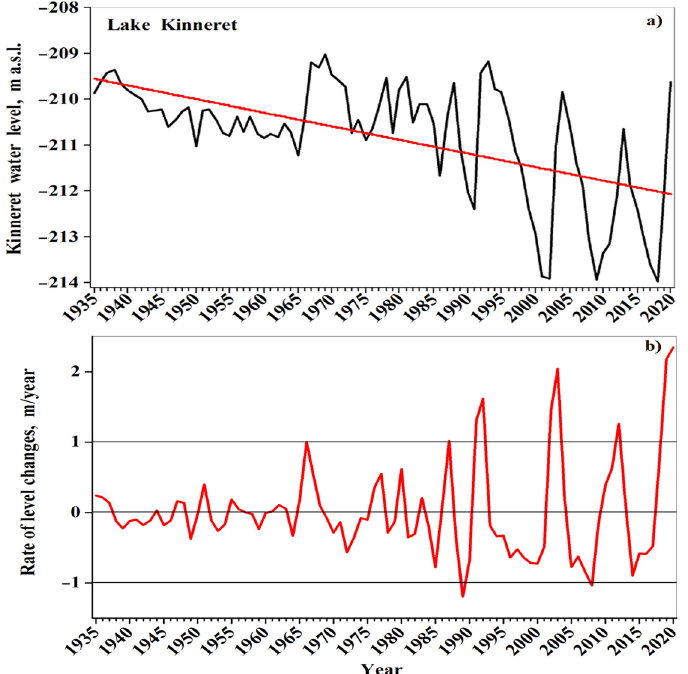
Figure 2. ( a ) Yearly data of the Kinneret water levels from 1935 to 2016; and ( b ) the rate of Kinneret water level changes from year to year. The straight red line designates a linear fit.